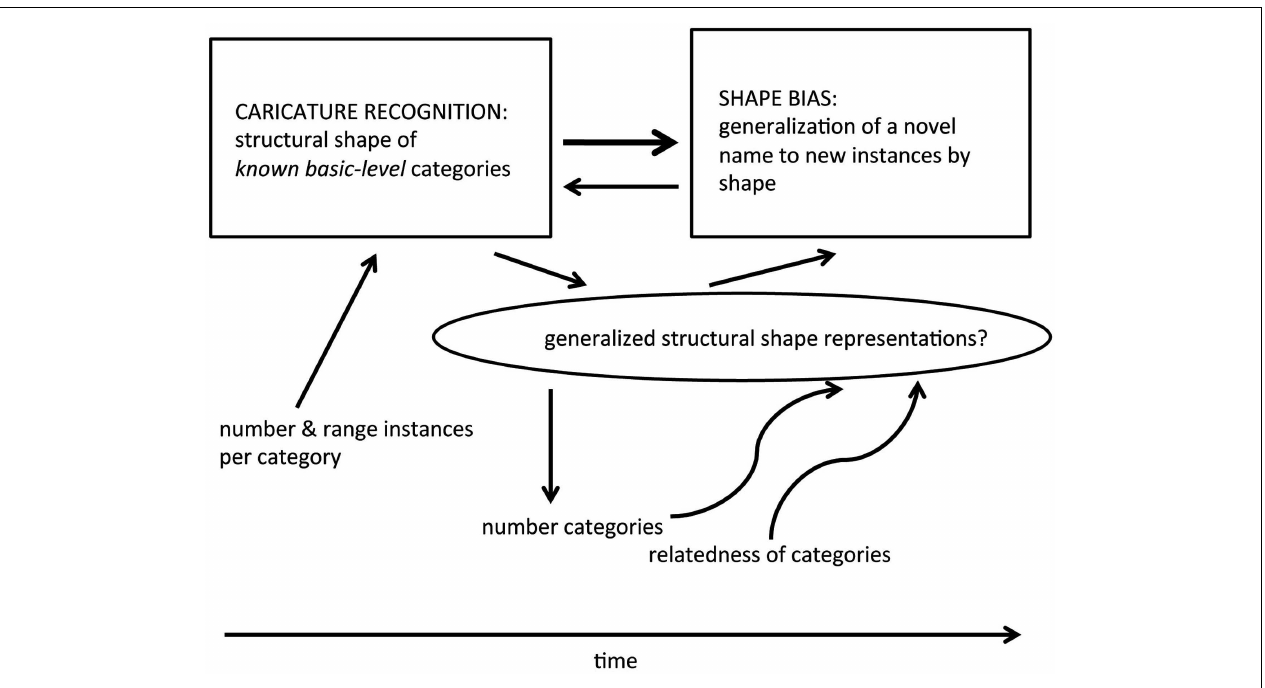
range of experienced instances and precedes and supports the development of the shape bias.The generalized ability to represent the structural shape of even novel things may be an intervening skill that may depend on the number and kind of known basic level